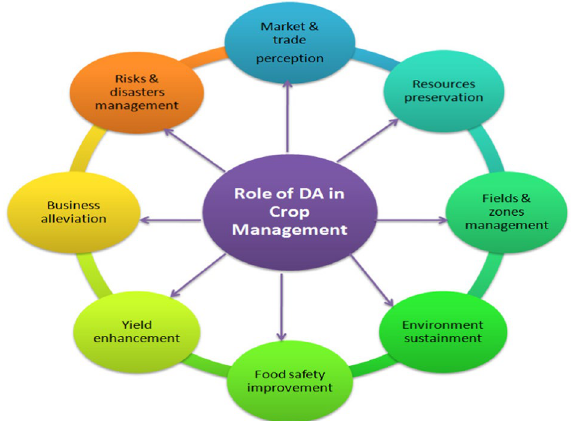
Fig. 2 Role of DA in crop production